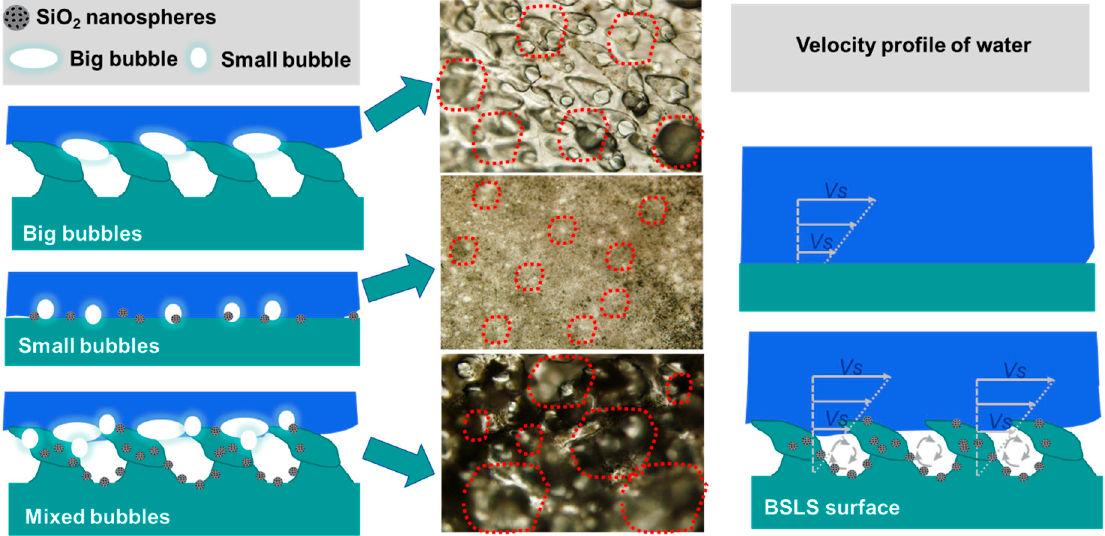
Figure 11. Antidrag and antifouling mechanism.